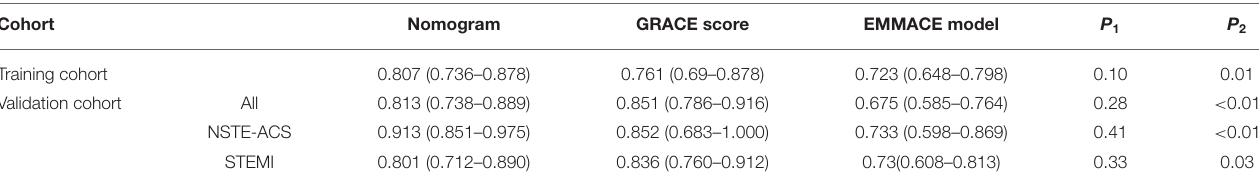
TABLE 4 | The AUC (95% CI) of different models in training cohort and validation cohort. Cohort Nomogram GRACE score EMMACE model P 1 P 2 Training cohort 0.807 (0.736–0.878) 0.01 Validation cohort